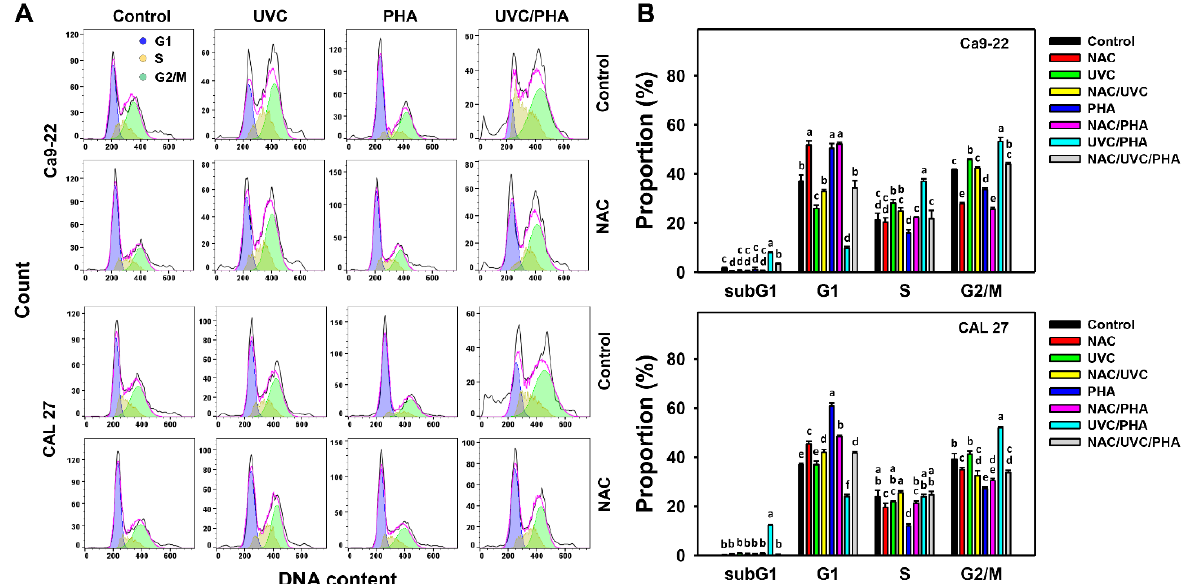
Figure 2. UVC/PHA-induced subG1 accumulation and G2/M arrest in oral cancer cells. In the presence or absence of NAC, oral cancer cells were grouped into four treatments, i.e., control, UVC, PHA, and UVC/PHA, for 24 h. The UVC and PHA treatment doses were 8 J/m 2 and 0.8 μ M, respectively. ( A , B ) Profile and data. For comparison, treatments labeled with different letters (a to e) produced significantly different results ( p < 0.05). Data are presented as mean ± SD ( n = 3 independent experiments, with each experiment involving 5000 gated cell counts).